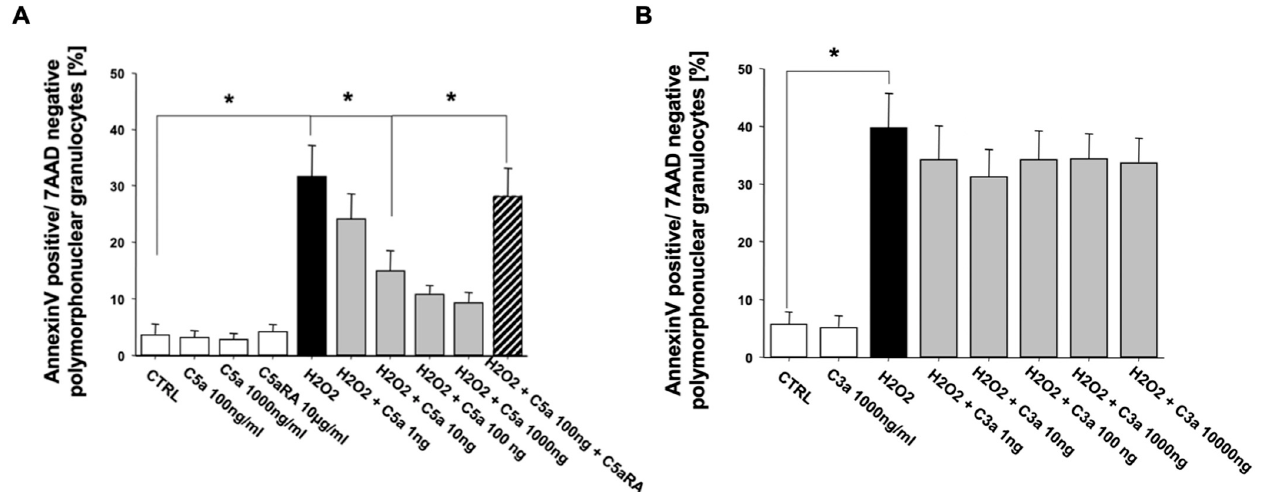
Figure 4. C5a ( n = 4) ( A ) but not C3a ( n = 3) ( B ) inhibits the intrinsic, H 2 O 2 -induced apoptosis rate of freshly isolated PMN from healthy male volunteers in a concentration-dependent manner. The percentage of apoptotic PMN was determined by Annexin-V/7-AAD staining and flow cytometry. C5aRA = C5aR1 specific small peptide inhibitor PMX53. Results are shown as mean ± SEM. * = p < 0.05.